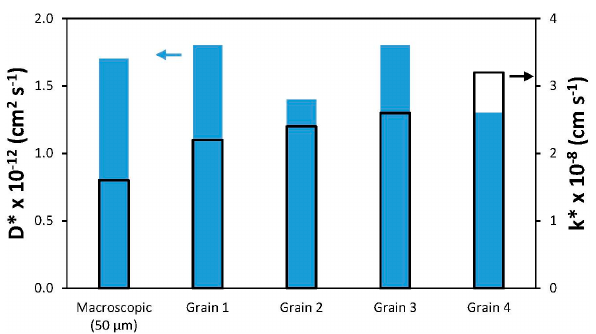
Figure 8. Depth profiling within individual grains in a polycrystalline LSCF sample exchanged at 450 °C in 18 O-enriched O 2 gas for 3721 s, using focused ion beam-secondary ion mass spectrometry (FIB-SIMS). ( a ) Microstructure, showing analyzed areas by ion-induced secondary electron image. Number labels in ( a ) identify grains from which the profiles plotted in ( b ) were obtained. Reprinted with permission of The Electrochemical Society, from [90] by Druce et al.